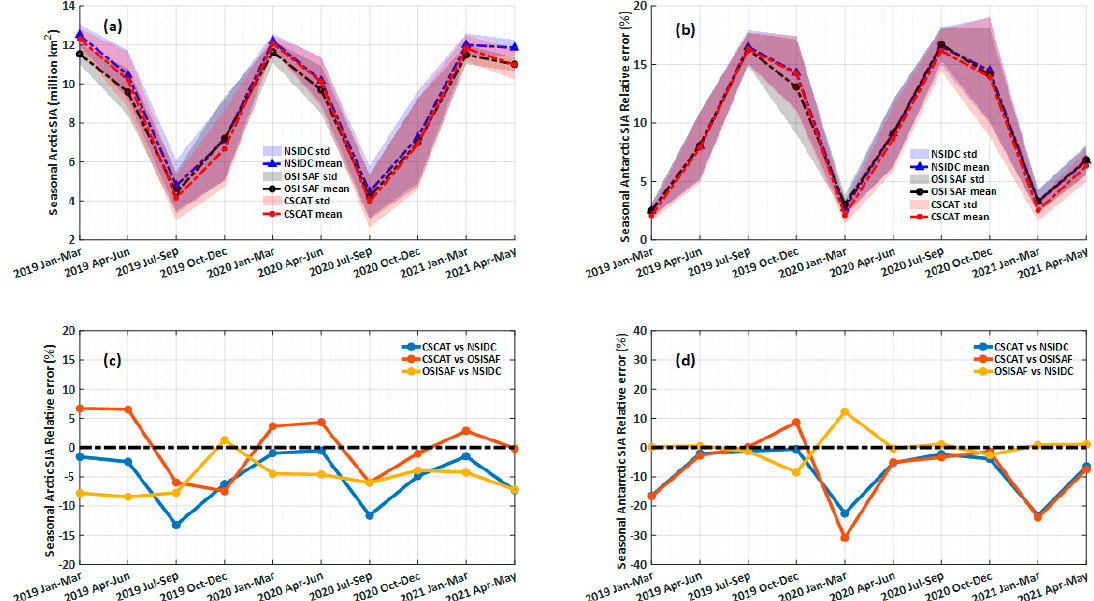
Figure 14. The mean values (dotted lines) and standard deviations (shaded areas) of seasonal sea ice areas from 1 January 2019 through 10 May 2021 for ( a ) the Arctic and ( b ) the Antarctic, respectively, where the blue, black, and red marked results represent NSIDC, OSI SAF, and CSCAT results, respectively. The seasonal sea ice area relative error for ( c ) the Arctic and ( d ) the Antarctic, respectively, where the blue, red, and yellow circled lines represent the comparison between CSCAT and NSIDC 40% SIC ice extent, between CSCAT and OSI SAF sea ice edge product, between OSI SAF sea ice edge product, and NSIDC 40% SIC ice extent, respectively.